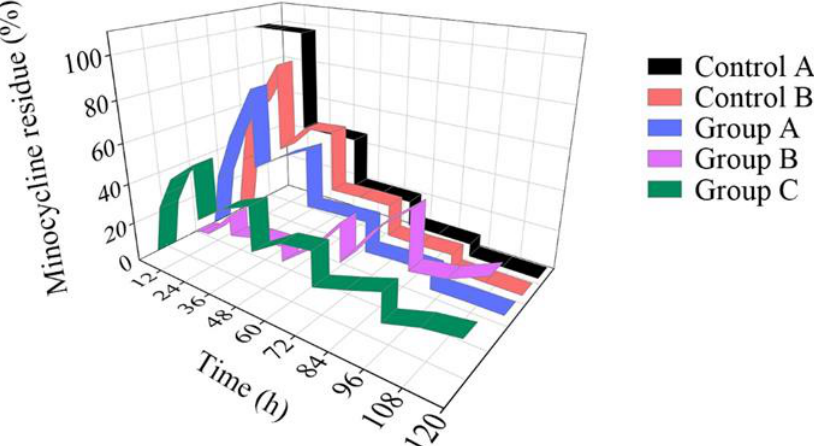
Figure 5. Minocycline residue over 120 h. For the solution (black belt) in the dish, the minocycline residue decreased rapidly. For the nanoparticles (red belt) in the dish and the solution in the microfluidic/chitosan device (blue belt), the amount of minocycline residue in the initial period was much higher than that in the terminal period. For the nanoparticles in the microfluidic/chitosan device (purple belt), the amount of minocycline residue in the initial period was much lower than that in the terminal period. When a mixture of the solution and the nanoparticles was loaded into the microfluidic/chitosan device (green belt), the minocycline residue was stable throughout the whole period.